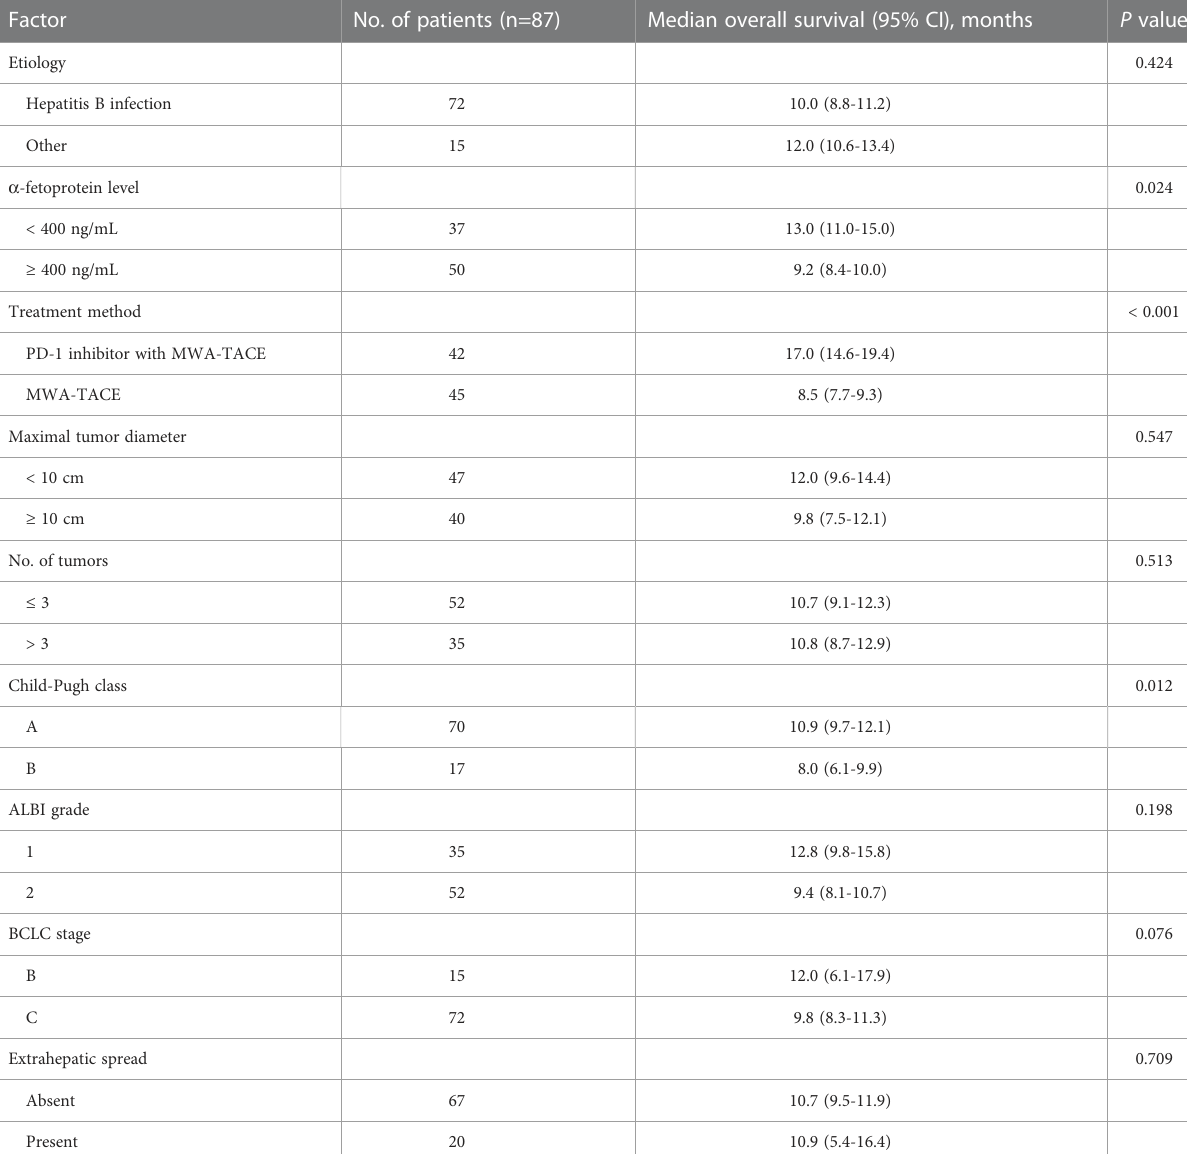
TABLE 4 Univariate Analysis of Prognostic Factors for Overall Survival.